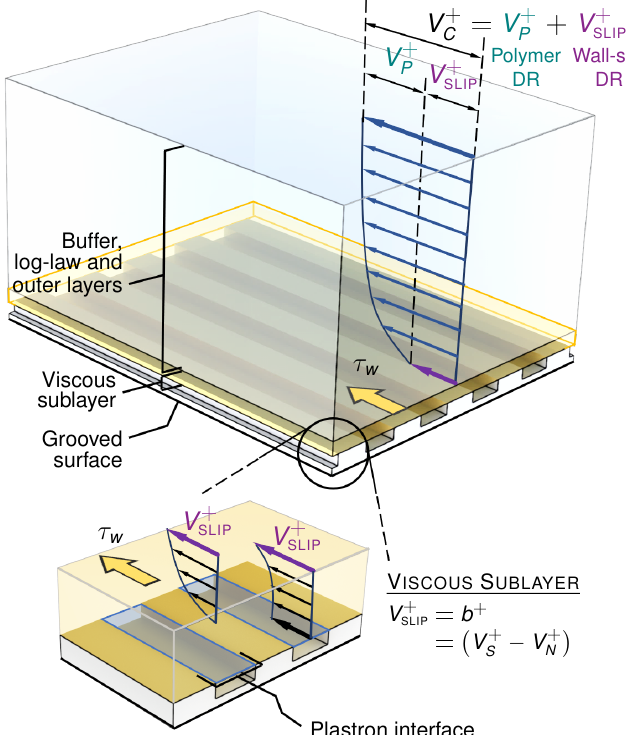
Figure 3. Schematic depiction of the additive two-layer model for combined drag reduction. The inset shows the thin near-wall viscous sublayer within which the composite boundary conditions are assumed to homogenize, yielding a uniform effective slip velocity V + Dimensions are merely illustrative and are not to